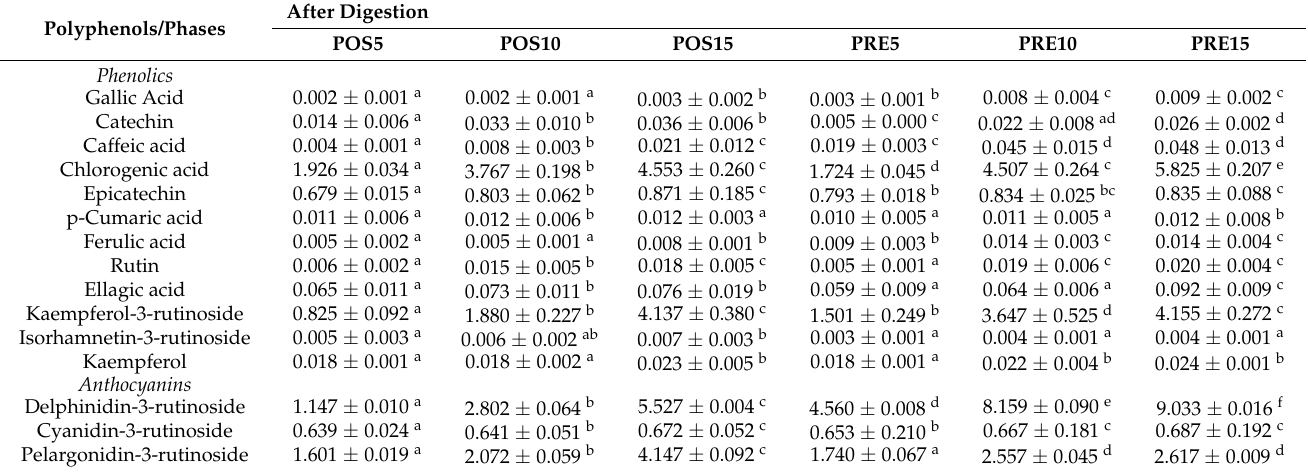
Table 4. Concentrations (mg/100 g yoghurt) of individual polyphenol in tamarillo fortified yoghurts after in vitro